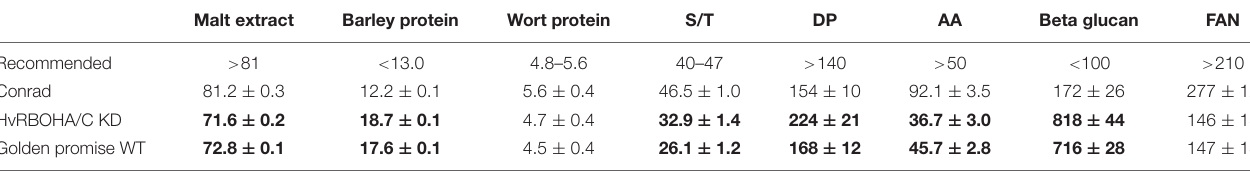
FIGURE 9 | Expression of the HvRBOH genes during different stages of malting in the HvRBOHA/C knockdown line and wildtype Golden Promise variety. Relative expression of each gene in various malting stages was with reference to their expression in dry seeds. Error bars represent standard error of the average cT values ( n = 4). ∗ Represent significantly different changes ( > log 2 -fold) in the HvRBOH expression when compared to their expression levels in the dry seeds ( p < 0.05). GAPDH was used for normalization. TABLE 2 | Malting quality of Conrad, HvRBOHA/C knock-down line and WT Golden Promise. Malt extract Barley protein Wort protein S/T DP Beta glucan